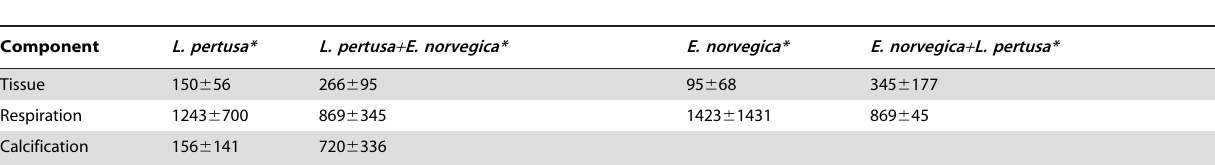
Table 1. Tracer C-partitioning between metabolic components of L. pertusa and E. norvegica separate and together. (n=3).